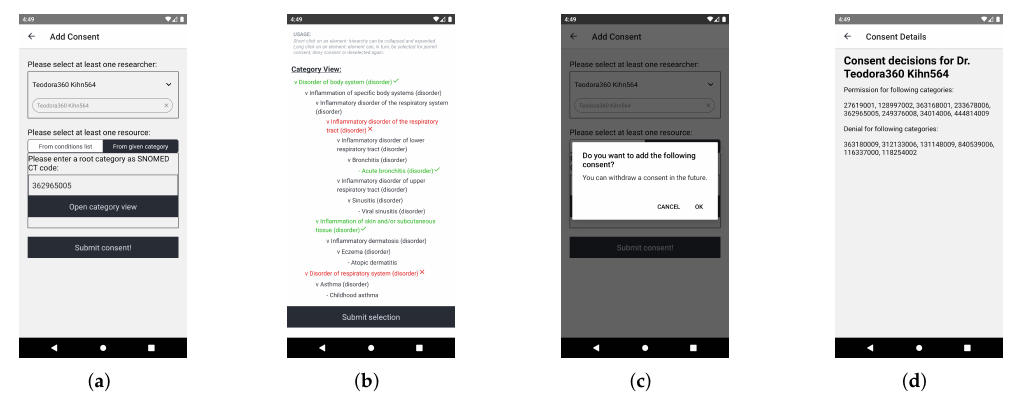
Figure 6. Screenshots of the Dynamic Consent implementation in the “Patient App”. ( a ) Add dynamic consent: Category selection view. ( b ) Category view: Selection example. ( c ) Submit consent. ( d ) Consent